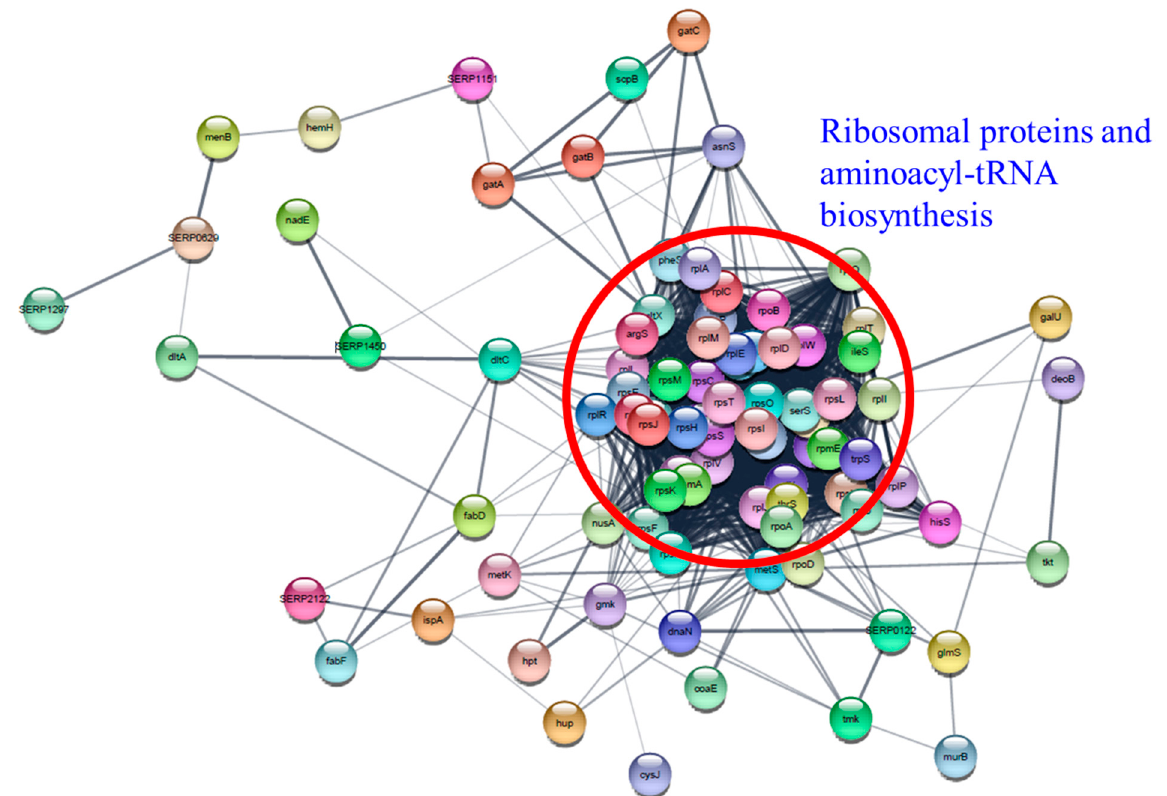
Figure 14. Protein–protein interaction network analysis of differentially expressed proteins associated with essential genes using STRING database and Cytoscape. Ribosomal proteins and aminoacyl-tRNA biosynthesis proteins were indicated by a red circle.